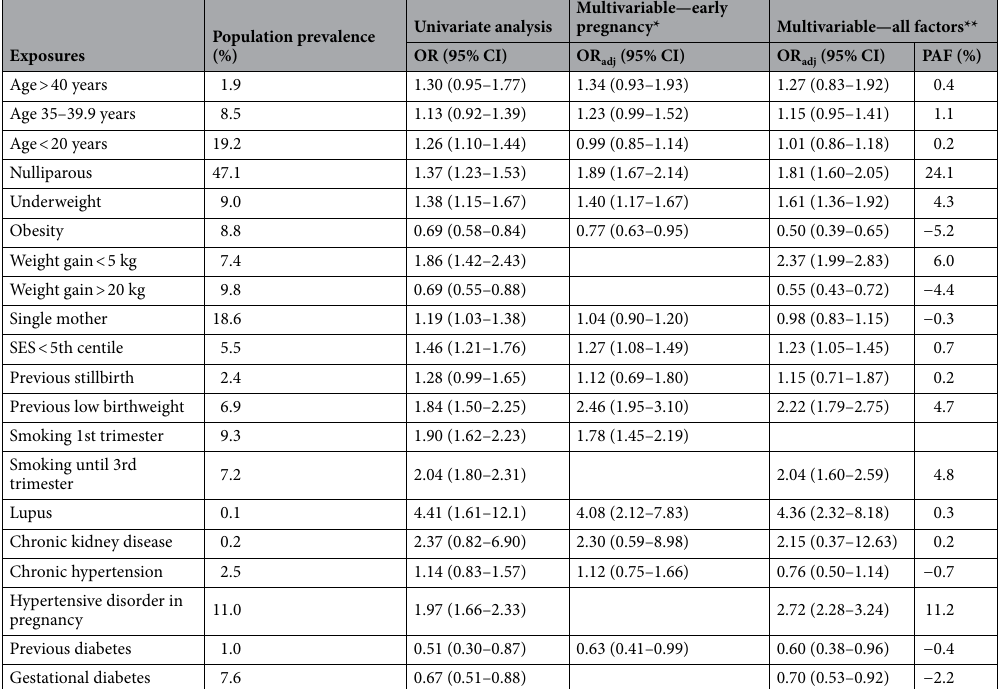
Table 2. Potential risk factors for SGA—Univariate and multivariate (early and all factors) analyses, population prevalence and population attributable fractions. SES socioeconomic status, OR odds ratio, CI confidence interval, PAF population attributable fraction, SGA small for gestational age. *Multivariable analysis adjusted for all early pregnancy factors. **Multivariable analysis adjusted for all pregnancy factors, except smoking 1st trimester which was replaced by smoking until 3rd